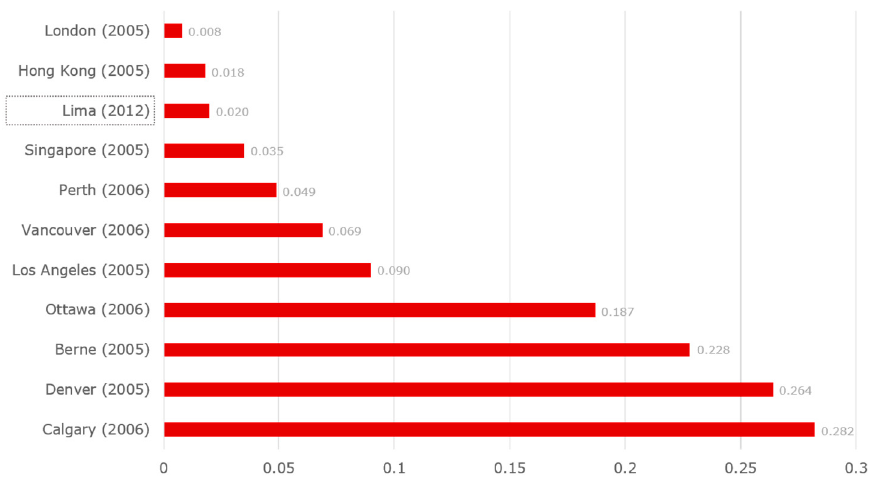
/ person). Source: [43,57,63]. Graph by Figure 10. Total freeway length per person (m/person). Source: [43,57,63]. Graph by authors. Figure 10. Total freeway length per person (m